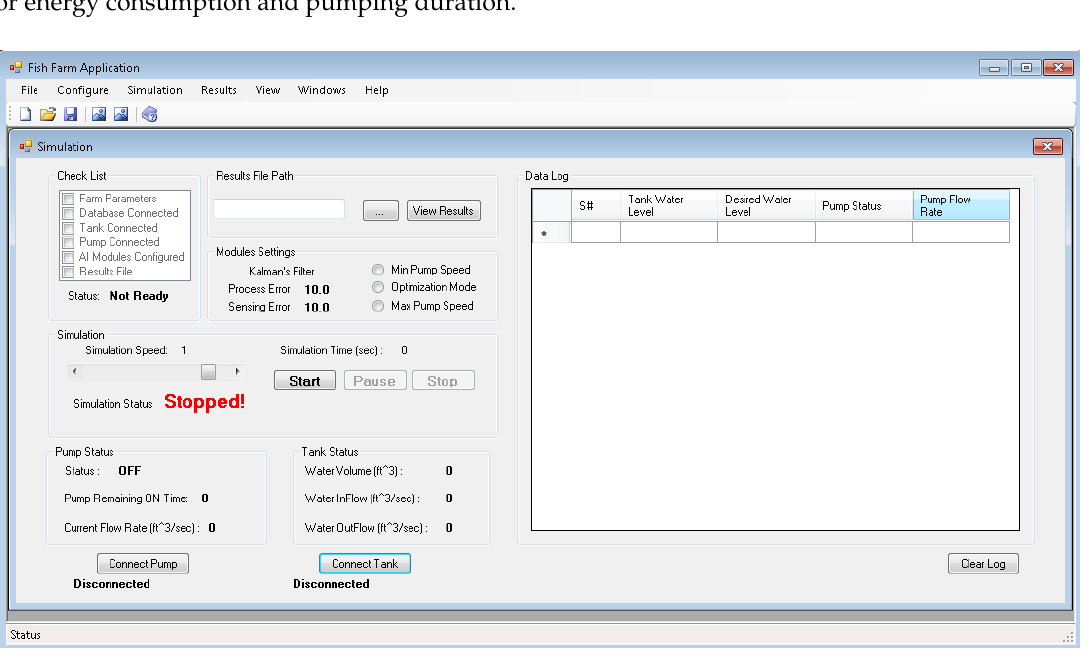
Figure 11. Fish farm simulator main window.